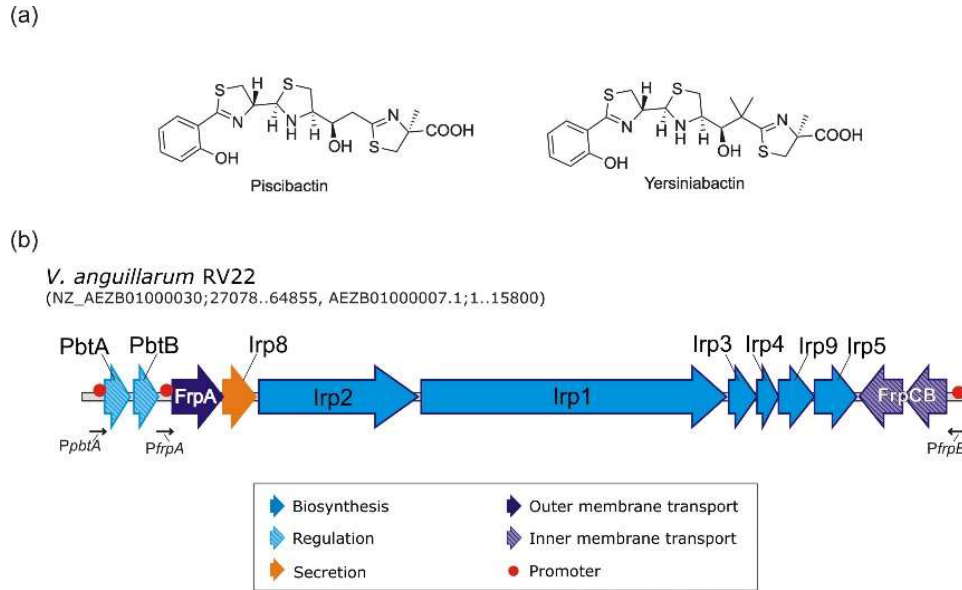
Figure 1. ( a ) Chemical structures of the siderophores piscibactin and yersiniabactin; ( b ) genetic map of irp gene cluster encoding piscibactin system in Vibrio anguillarum [7]. Most siderophores are synthetized by multimodular non-ribosomal peptide synthetases (NRPSs) and polyketide synthases (PKS) from the assembly of different amino acid and polyketide moieties, respectively. Each module of a NRPS/PKS incorporates a single precursor into the nascent product that will remain covalently attached to the peptidyl carrier protein (PCP) domain [13]. Thus, the final product must be released from the final PCP by a C-terminal type I thioesterase (TE) domain present in the last NRPS/PKS of the (proteins Irp123459) related to piscibactin biosynthesis [6,7] and regulation (PbtAB)